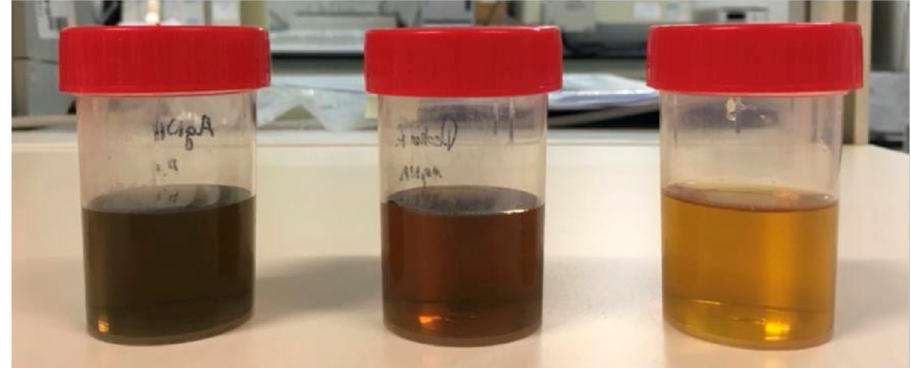
Figure 1. Macroscopic appearance of samples prepared by methods A, B and C (from left to right